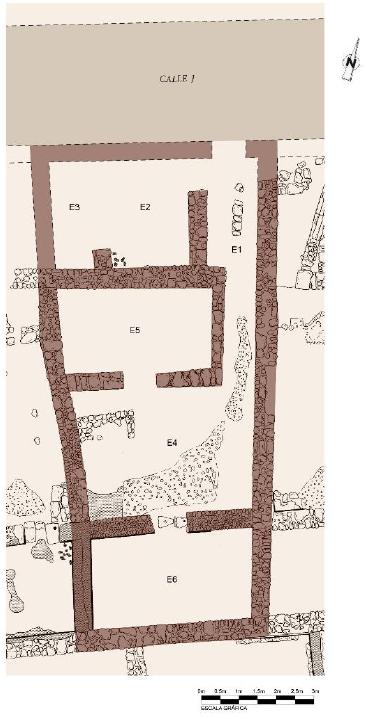
Figure 22. House 105, Variant 5. Plan and room distribution.